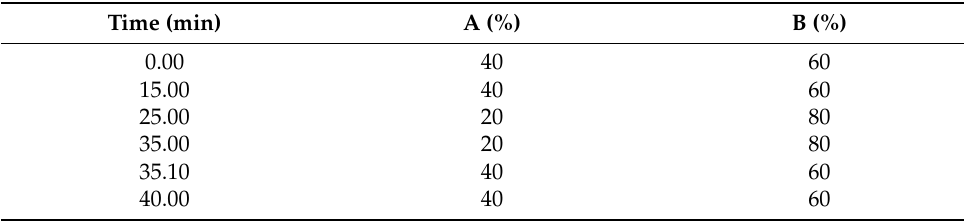
Table 3. HPLC-DAD-UV/VIS mobile phase gradient elution